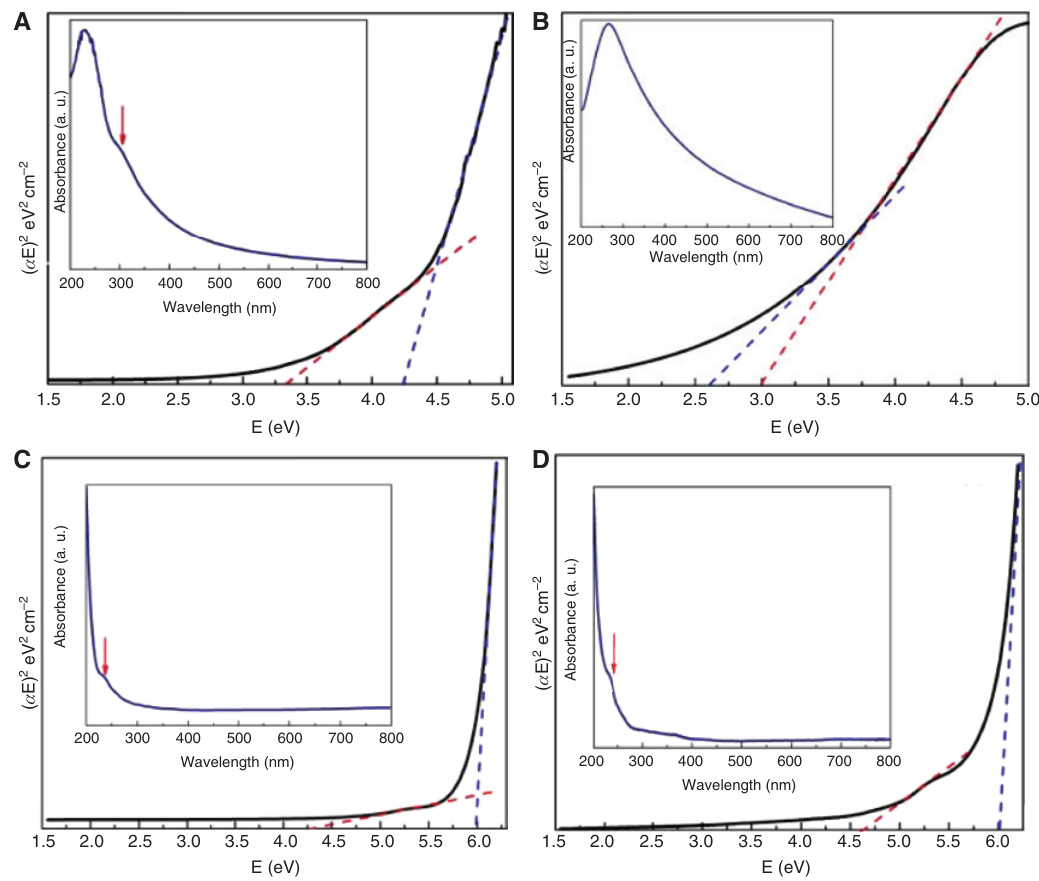
Figure 3: Tauc plot and absorbance spectra (inset) of GO and MgO-GO samples. (A) GO, (B) MgO-GO1, (C) MgO-GO2, (D)